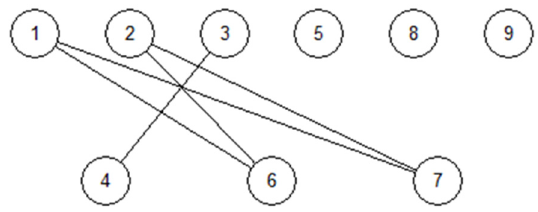
Figure 2. Hasse diagram of the nine nerve agents based on the four indicators given in Table 3. Obviously, the diagram has a rather low level of information, with only 5 comparisons and 31 incomparisons. However, virtually all data applied originate from calculations [29]. Thus, they should be taken with some caution. The dominance of incomparabilities is a clear signal that the calculated values [29] alone would mask the role of other factors. Here, two separate methods have been applied, both available as special modules of the PyHasse software: (1) introducing weight regimes and (2) introducing indicator noise/uncertainty.